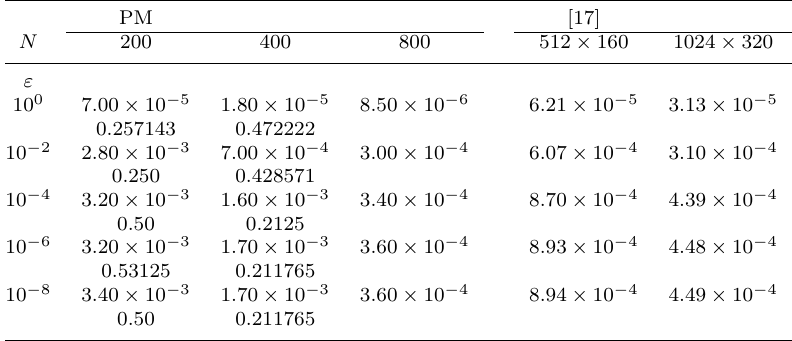
Max point-wise error ( E Y N,n ( x,t ) = Max |Y 2 N,n ( x,t ) − Y N,n ( x,t ) | , ( x,t ) ∈ D ) and error ratio E Y 2 N,n / E Y N,n for Example 4. PM [17]